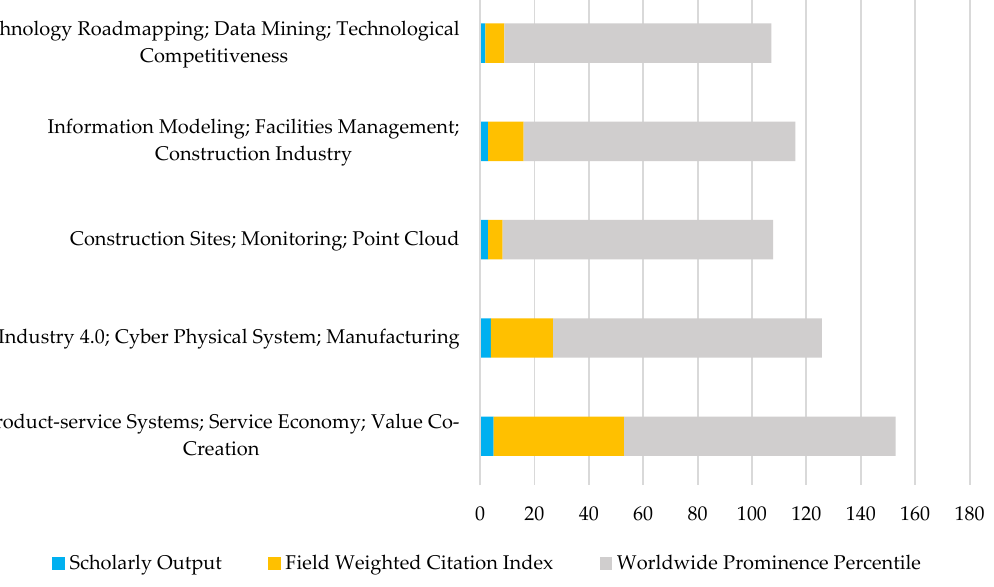
Figure 4. The most dramatic increases in the use of “Industry 4.0” coincide with the global outbreak of COVID-19.